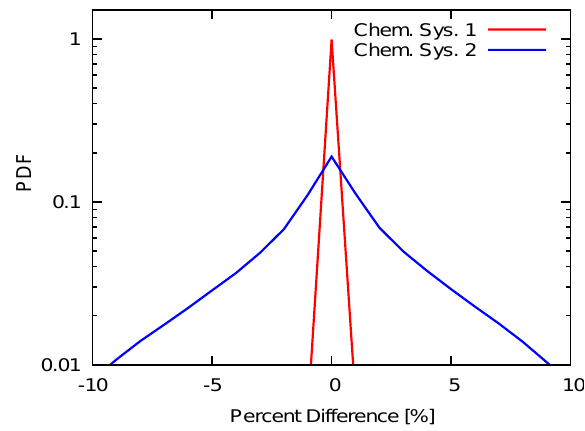
Fig. 7. Probability density function for the errors E (red) and ˜ E (blue) [%] for specific settings of the concentrations X and Y , which minimise the errors: 10ppbv ≤ X ≤ 20ppbv; 0.1ppbv ≤ Y ≤ 1ppbv.